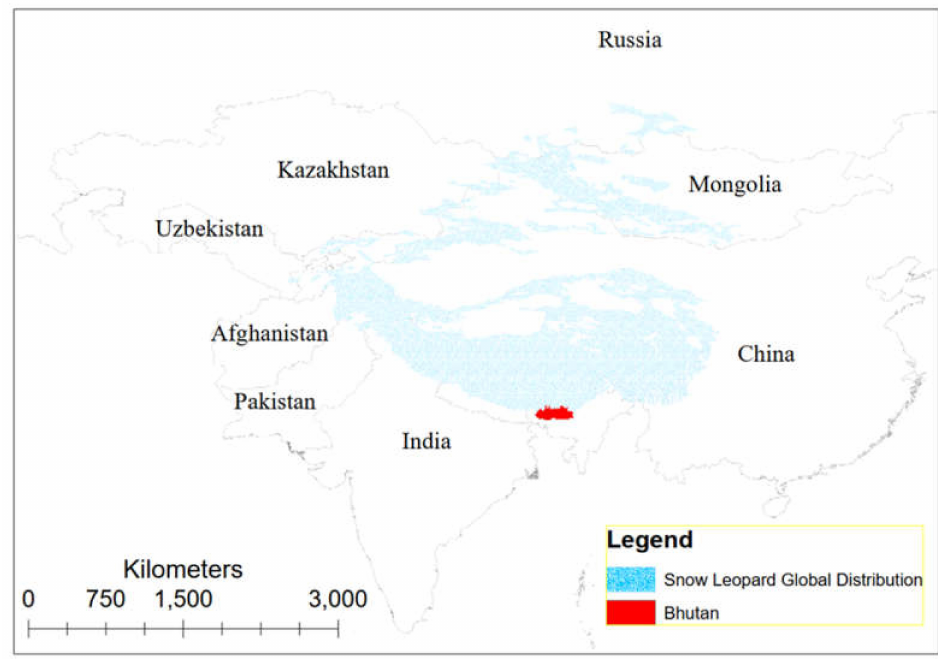
Figure 5. The snow leopard range countries are also connected through the Shanghai Cooperation Organization (SCO) except